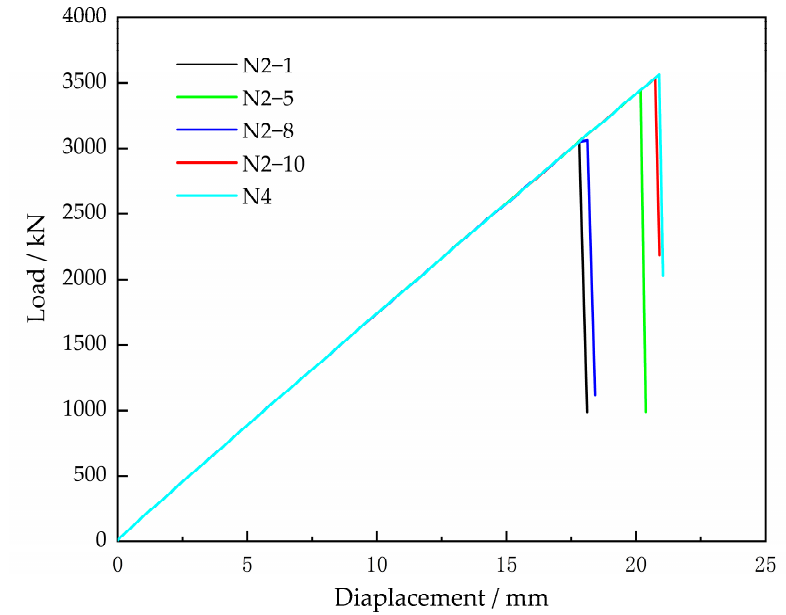
Figure 16. Comparison between the partial prediction results of the N2 group and the N4 group.